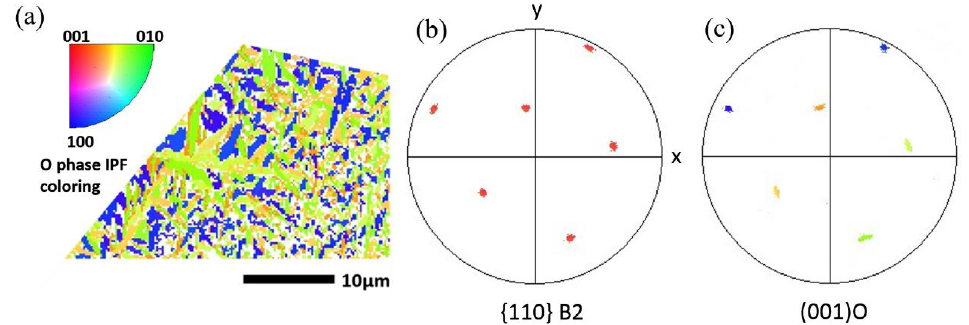
Figure 7. ( a ) IPF map, ( b ) pole figures of {110}B2, ( c ) pole figures of (001)O in #3 B2 grain. As shown in Figure 8a, the purple lamellar O phase formed a cluster structure and grew into the #1 B2 grain. The pole figures of the purple O WGB with the #1 B2 pole figure are shown in Figure 8b. The {001} plane of the purple O WGB is parallel to the {110} plane of the #1 B2 grain, and the < 110 > direction of the O WGB is also parallel to the < 111 > direction of the #1 B2 grain. Thus, the O WGB maintained the specific orientation relationship, i.e., (001)O//{110}B2 and <110>O//<111>B2, with one of the two adjacent B2 grains. The grain boundary was decorated by O phases with different colors as shown in Figure 8a by the black arrows. This indicated that different crystallographic variants of the O phase pre- cipitated simultaneously at one B2 grain boundary and formed the O GB . It is known that the positions where the grain boundary and crystal defects gather are possible nucleation sites. Therefore, it can be inferred that there can be more than one nucleation site for the O phase on a single B2 grain boundary during the cooling process. The pole figures of the orange O GB and the cyan O GB with the #1 B2 pole figure are shown in Figure 8c,d, respec- tively. Similar to the purple O WGB , the orange O GB kept a specific orientation relationship with the #1 B2 grain. As seen from Figure 8d, the cyan O GB did not have a specific orien- tation relationship because the < 110 > direction of the cyan O GB is not strictly parallel to the < 111 > direction of the #1 B2 grain. However, the {001} plane of the cyan O GB is parallel to the {110} plane of the #1 B2 grain. This indicated that the cyan O GB held a near-orientation relationship with the #1 B2 grain based on this plane relation. It was pointed out that the